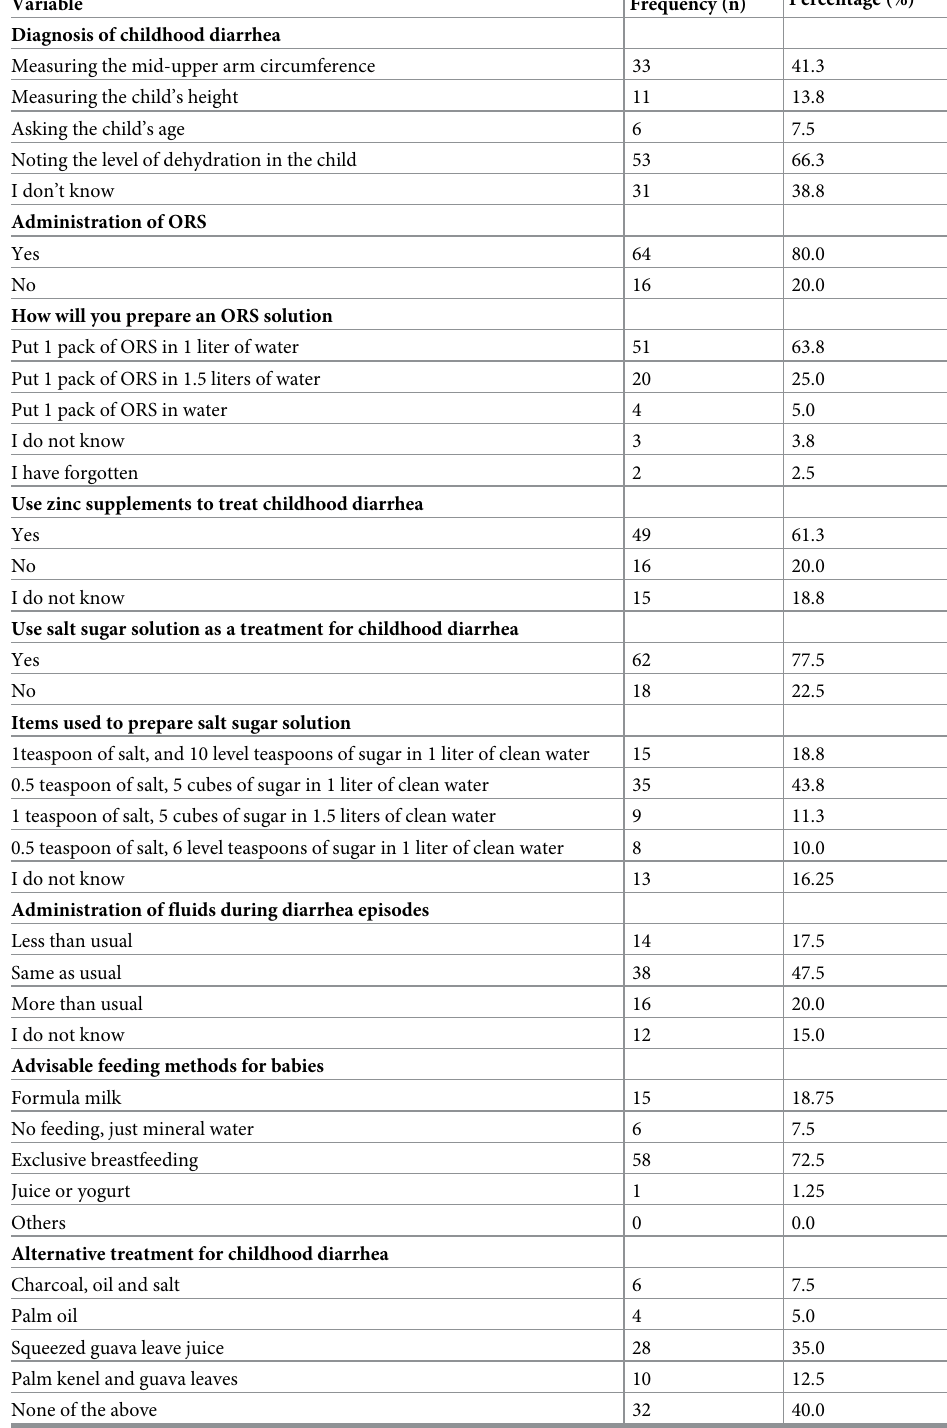
Table 9. Practices on the management and prevention of childhood